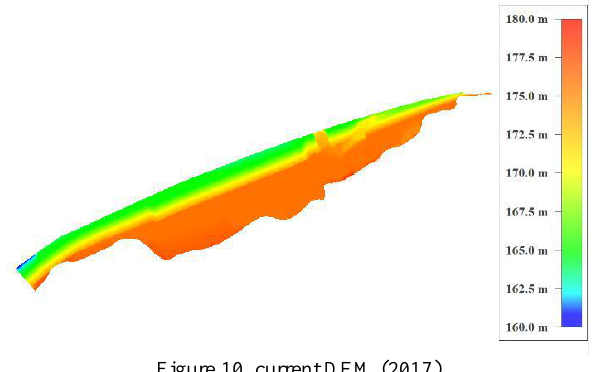
Figure 10. current DEM (2017)